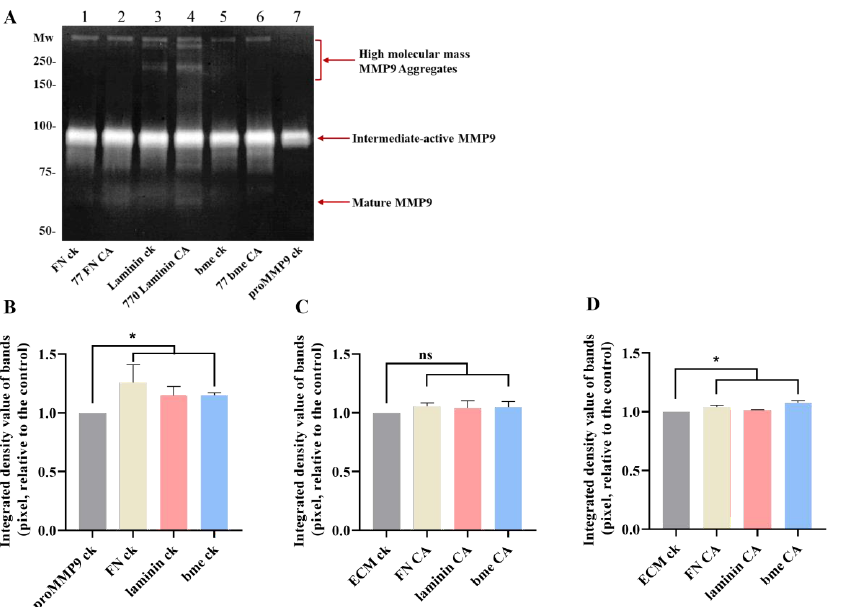
Figure 11. Effect of ECM protein chloramines on proMMP9 activation determined by gel zymography. Chloramines were generated on FN, laminin and bme, as described in the legend to Figure 10, and we then selected molar excesses of these chloramines (77-fold molar excess for FN CA and bme CA, 770-fold molar excess for laminin CA, as indicated), or comparable concentrations of the parent proteins (indicated as FN ck, laminin ck and bme ck), incubated with proMMP9 (26 nM, 2 μg mL −1 ) for 24 h at 37 °C. Samples of proMMP9 were also incubated in the absence of added protein or chloramines (lane labeled proMMP9 ck). The chloramine concentrations chosen for this study are those which showed the maximum activity (see Figure 10). After incubation, the samples were subjected to: ( A ) Gel zymography (see Section 2), with a representative gel image presented from 3 independent experiments. Panels B – D present densitometry data from the combined dataset for: ( B ) the active intermediate MMP9 band of FN, laminin and bme control at ~92 kD compared with proMMP9 ck; ( C ) the active intermediate MMP9 band of FN CA, laminin CA and bme CA at ~92 kD, compared with the corresponding nontreated protein controls; ( D ) the mature MMP9 band at ~67 kD, as determined by ImageJ analysis. The densitometric data are mean pixel intensities ± SDs expressed relative to the control (lane labeled proMMP9 ck) from 3 independent experiments. Statistical analysis was performed using unpaired t tests with Welch’s correction for multiple comparisons, with statistical significance compared with the control indicated by *.